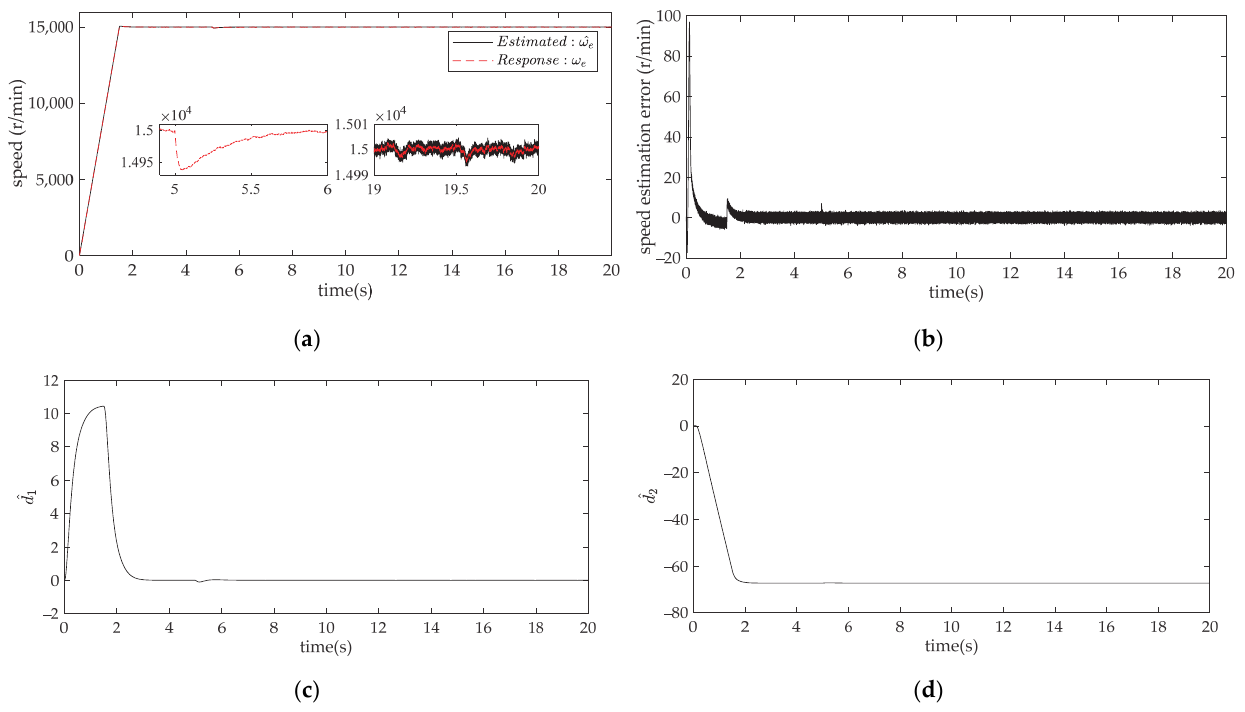
Figure 5. ( a ) Speed estimation of the improved sliding mode observer; ( b ) Estimation error; ( c ) Esti ‐ mated value of d 1 ; ( d ) Estimated value of d 2 .